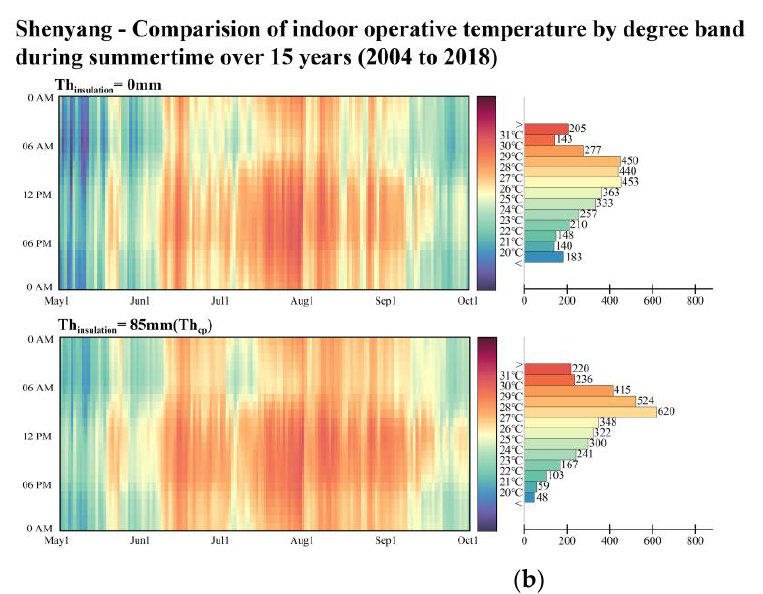
Figure 9. Left-hand side shows indoor operative temperatures of the south-facing bedrooms in Harbin ( a ) and Shenyang ( b ) (divided into various temperature degree bands); right-hand side shows numbers of hours of each temperature band.